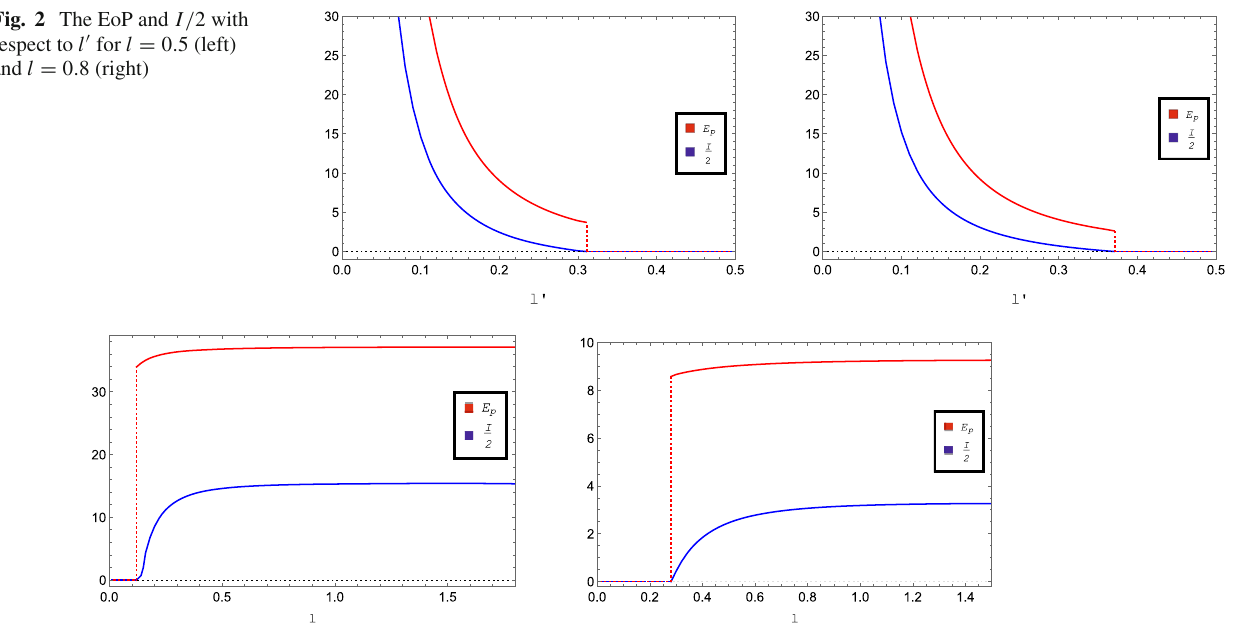
and l = 0 . 8 (right)